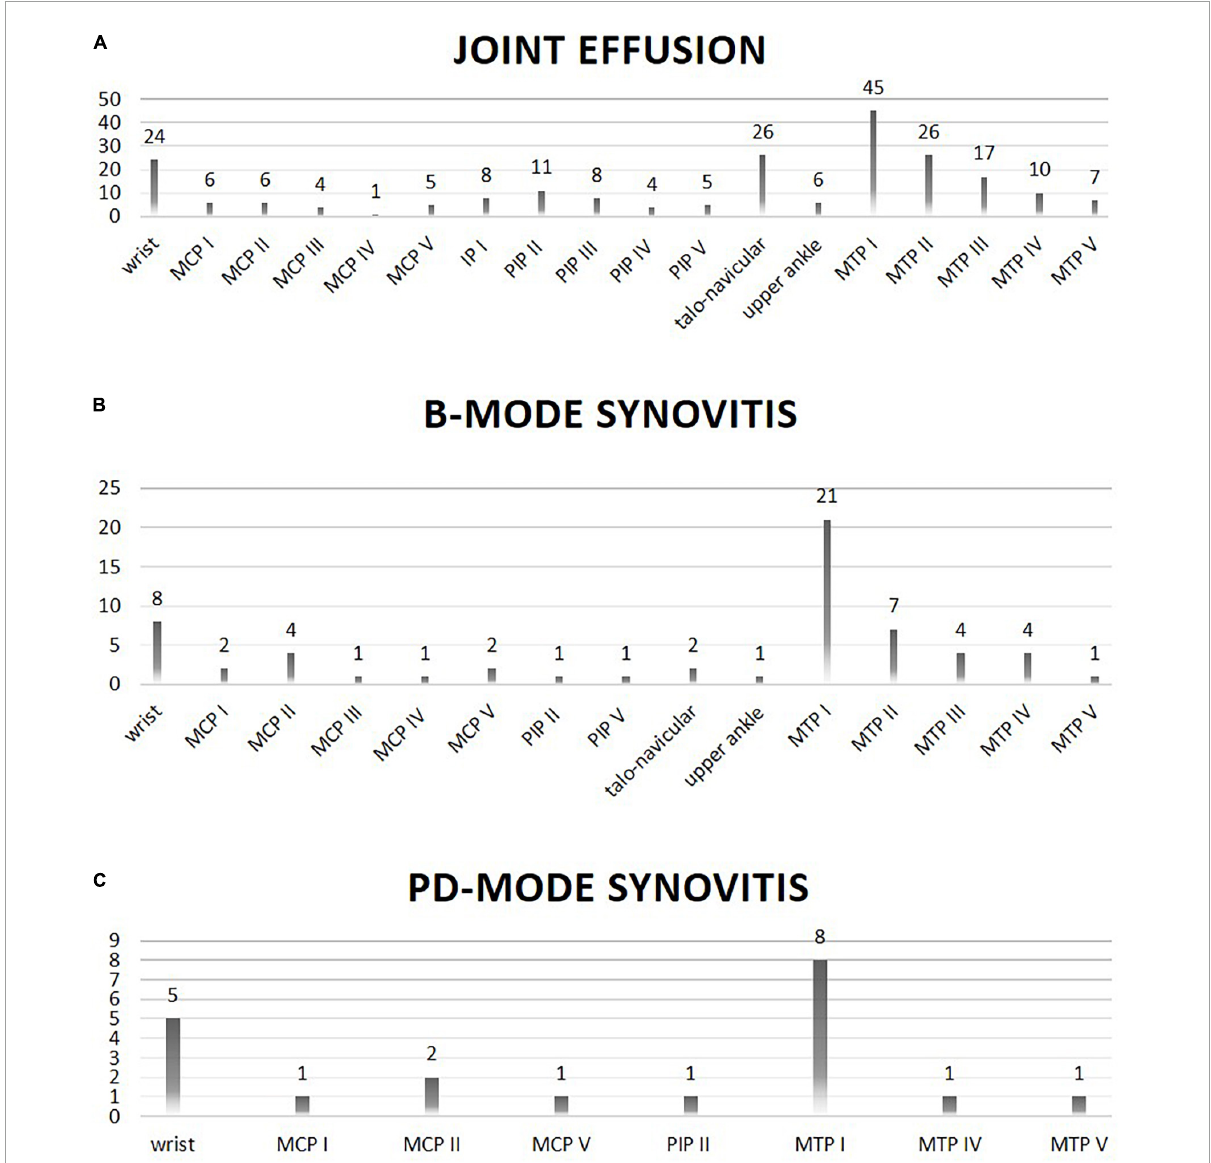
FIGURE2 Location (X-axis) and frequency (Y-axis; absolute numbers) of joint involvement on ultrasound evaluation is shown. Panel (A) shows joints with effusion on ultrasound evaluation. Panel (B) shows joints with B-mode synovitis on ultrasound evaluation. Panel (C) shows joints with PD-mode synovitis on ultrasound